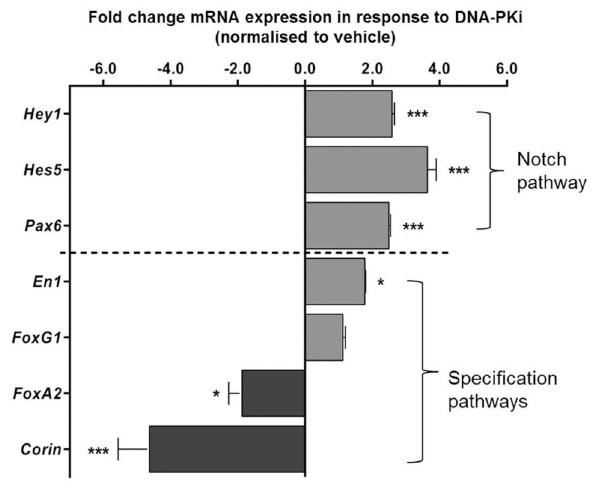
Figure 5. DNA-PK inhibition promotes regional specification and upregulation of Notch pathway transcripts. Real-time PCR analyses for transcripts of Notch signaling and regional specification using Lmx1a+ progenitors after isolation by flow cytometry. Cells exposed to DNA-PKi for four days (days 4-8), significantly (p<0.01) upregulated the Notch effector genes Hes5 and Hey1 as well as the Notch target, and RG marker Pax6 , by day 8. Incubation with DNA- PKi during this period also upregulated expression of the midbrain marker Engrailed 1 (En1), however, expression of forebrain marker (FoxG1), also known as brain factor 1 (BF-1), was unchanged in these cultures. DNA-PKi-incubated cells also significantly downregulated the expression of FoxA2 and Corin , two markers that demarcate progenitors of the ventral neural tube. Data presented as mean ± SEM of at least four independent experiments ***p<0.001, **p<0.01 and *p<0.05, respectively, using one-way ANOVA with Bonferroni’s post-hoc test, n=3.